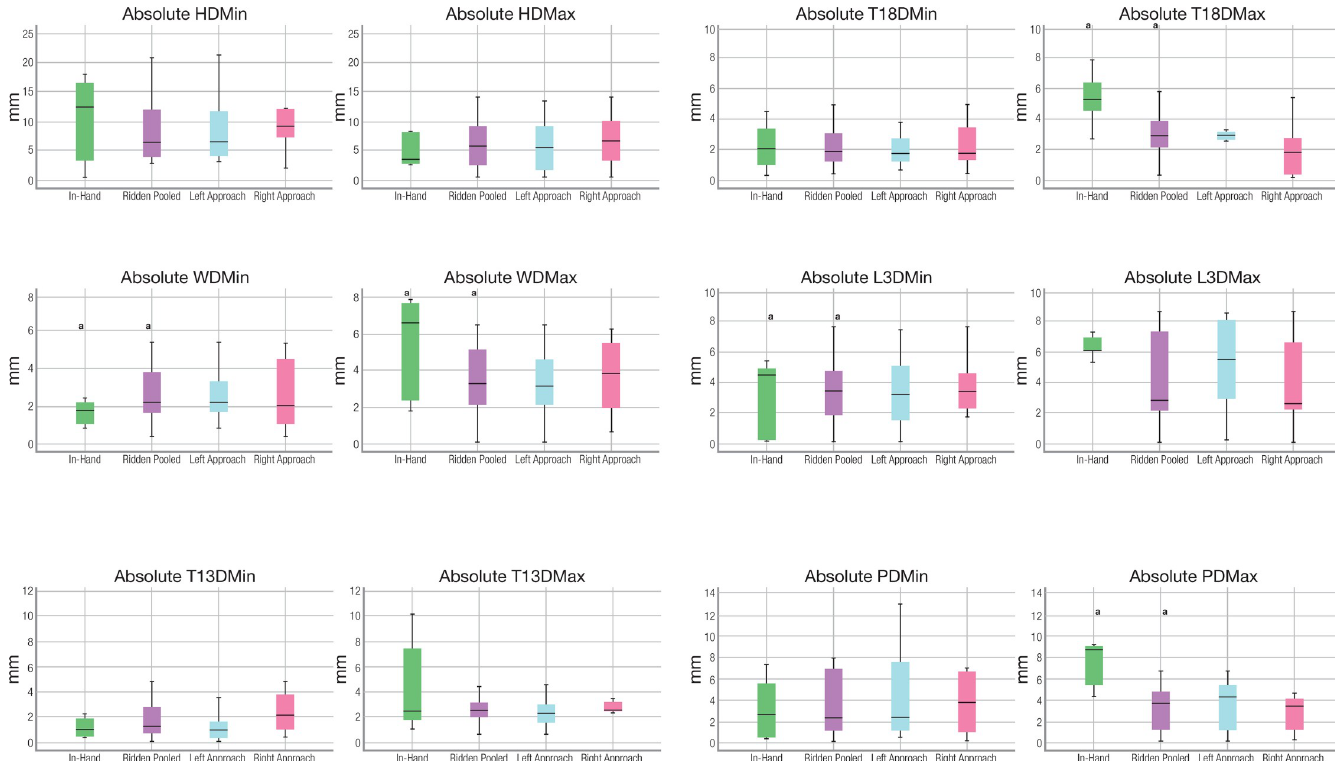
Fig 3. Symmetry movement values of the thoracolumbosacral regions. Boxplots displaying absolute minimum difference Head (HDMin), WD Min , T13D Min , T18D Min , L3D Min and Pelvis (PDMin) in mm: Difference between the two minima in vertical (z) displacement observed during the two diagonal stance phases in trot and absolute maximum difference (HDMax), WD Max , T13D Max , T18D Max , L3D Max and Pelvis (PDMax) in mm: Difference between the two maxima in vertical (z) displacement observed after the two diagonal stance phases in trot from eight horses (due to transmission technical issues, two horses data was lost). The central line represents the median; the box represents the 25th and 75th percentiles; and the whiskers represent the maxima and minima not considered to be outliers; ˚ represents outliers and � represents extreme outliers. ‘a’ represents the pairwise differences (P = < 0.05) between conditions. When comparing the in-hand trot with sitting trot (left and right approaches pooled), absolute symmetry values were closer to zero (indicating increased symmetry) and significantly different for WD max (P = 0.02) T18D max (P = 0.04), L3D min (P = 0.04) and PD max (P = 0.01). No differences were found between the remaining parameters or when comparing left and right